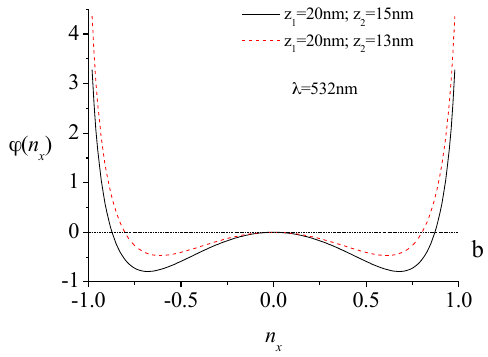
n ϕ n ϕ (solid) and ( ) ml x free x n ϕ x